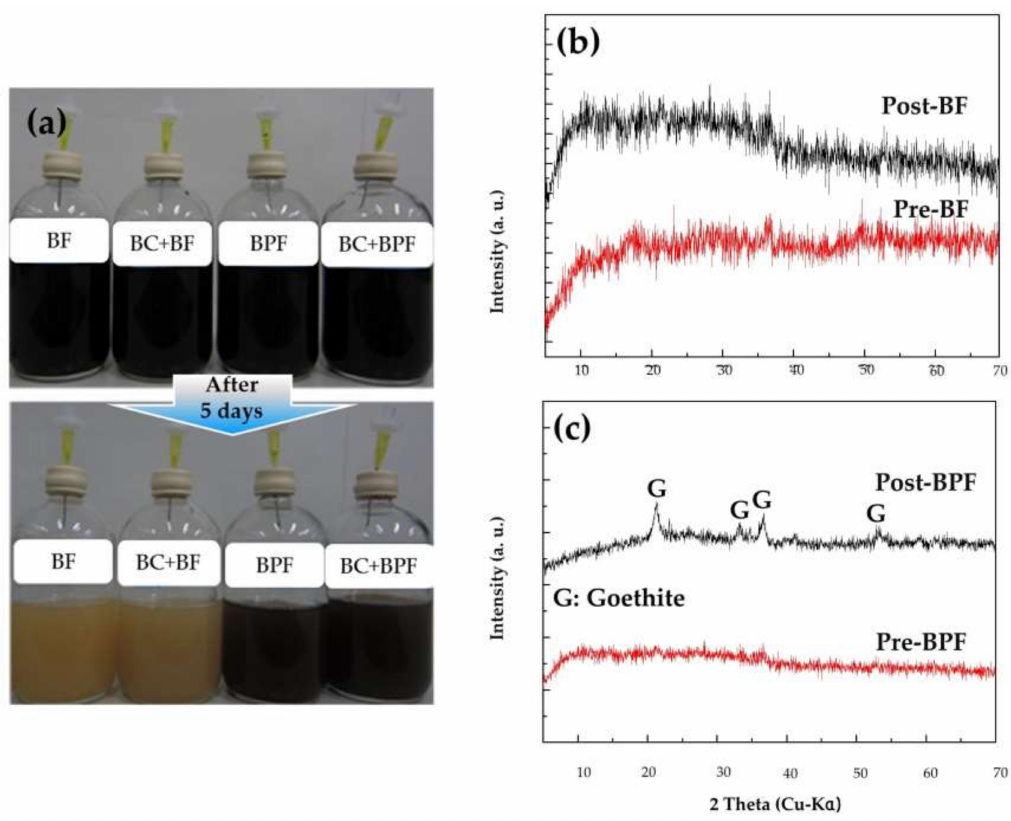
Figure 4. Changes in colors: ( a , upper) pre-BF, BC + BF, BPF and BC + BPF in single nitrate reactors and ( a , lower) Post-BF, BC + BF, BPF, and BC + BPF in single nitrate reactors. XRD patterns of ( b ) pre- and post-BF and ( c ) pre- and